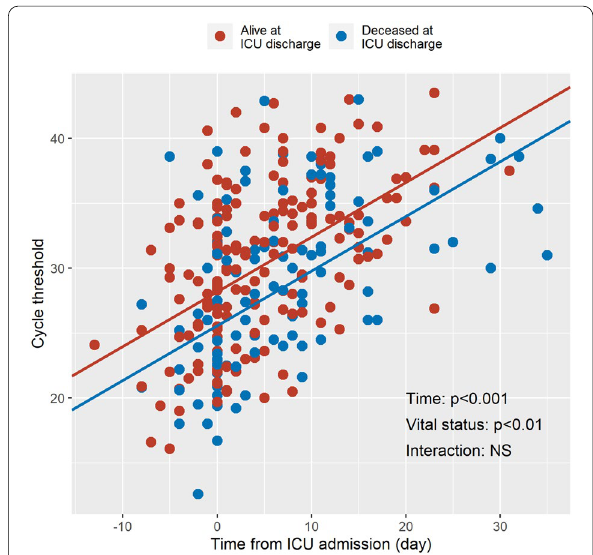
Fig. 1 Viral load as a function of time from ICU admission in positive RT‑PCR samples. Circles are individual RT‑PCR measurements expressed as cycle threshold values (the lower the cycle threshold, the higher the viral load). Red and blue circles refer to patients alive and deceased at ICU discharge, respectively. Lines are regression lines for both groups, adjusted for the site of sampling (nasopharynx or